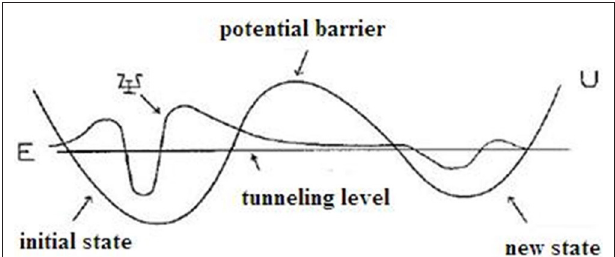
FIGURE 4 | Diagrammatic representation of quantum tunneling effect in quantized wave